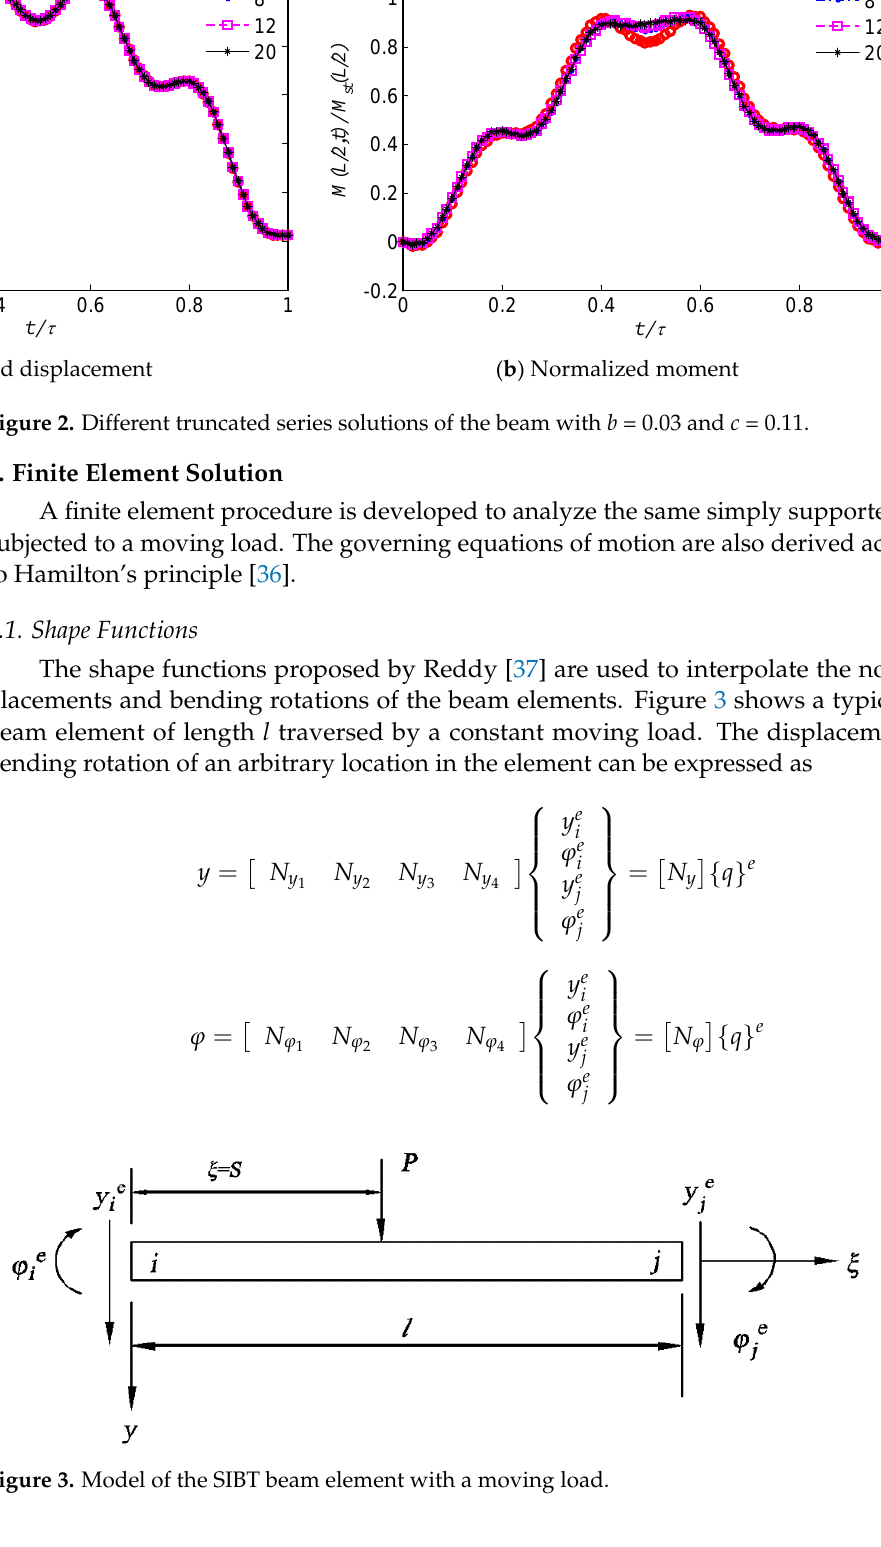
Figure 3. Model of the SIBT beam element with a moving load.